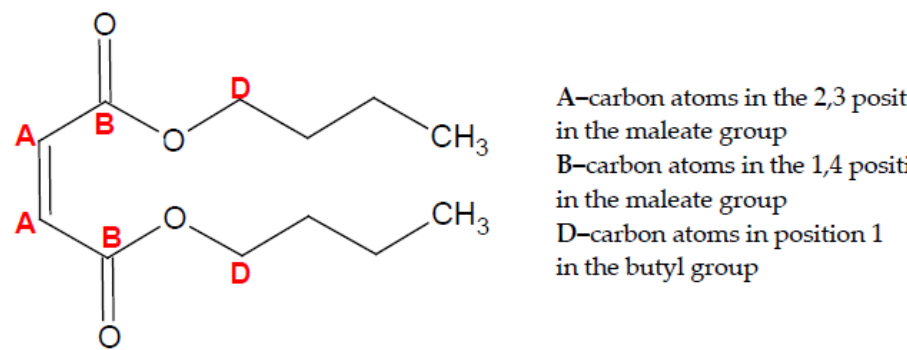
Figure 2. Nomenclature of the positions of carbon atoms in the dibutyl maleate molecule. If all oxygen atoms in the fuel molecule react according to the same scheme during combustion, the proportion of individually labeled atoms in the combustion products should be the same as in the fuel. The results presented in [50] indicate that this is not the case with dibutyl maleate.